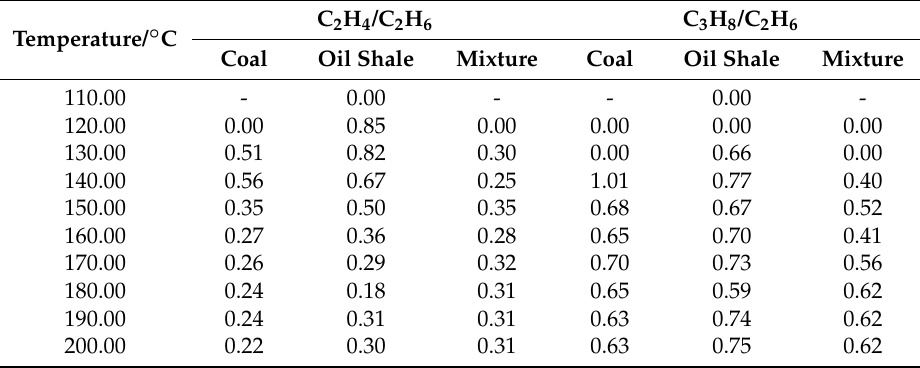
Table 2. Programmed heating experiment results (C 2 H 4 /C 2 H 6 , C 3 H 8 /C 2 H 6 ).